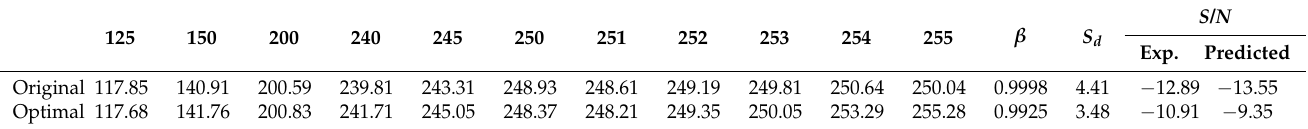
Table 4. The relationship between the original design and the optimal design of the self-made simulated rapid test strip. 125 150 Original 117.85